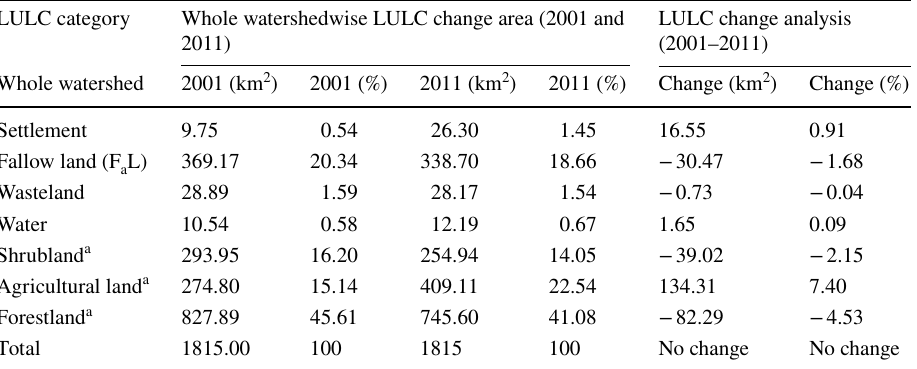
a Shows the inversely proportional relationship with the